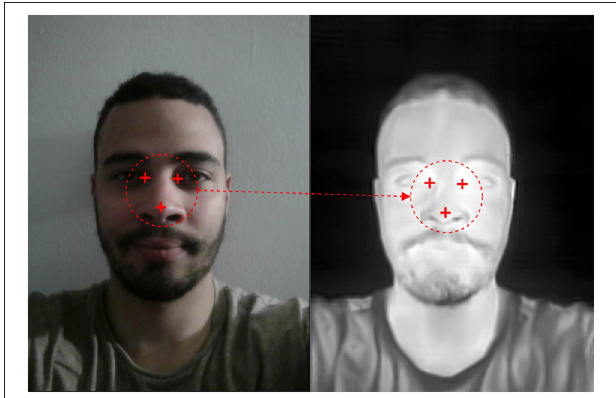
FIGURE 6 | Idea behind the RGB-thermal mapping